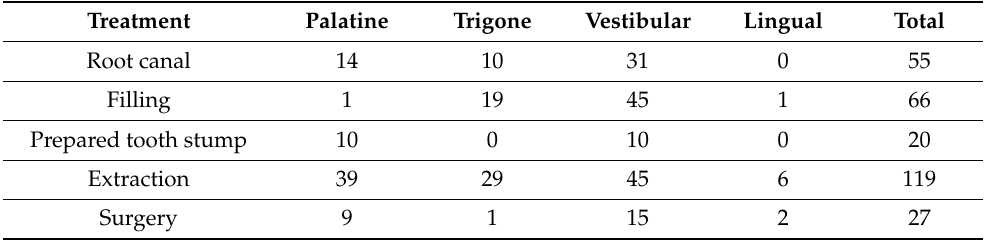
Table 1. Frequency distribution table based on the area of injection and the type of treatment.